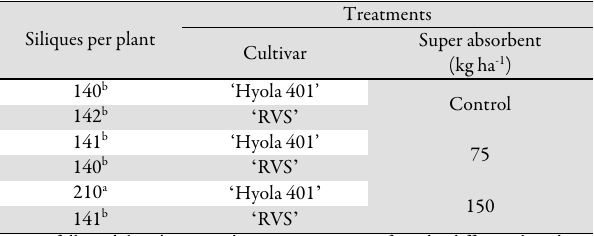
Table 4. Siliques number per plant as influenced by super absorbent rate and